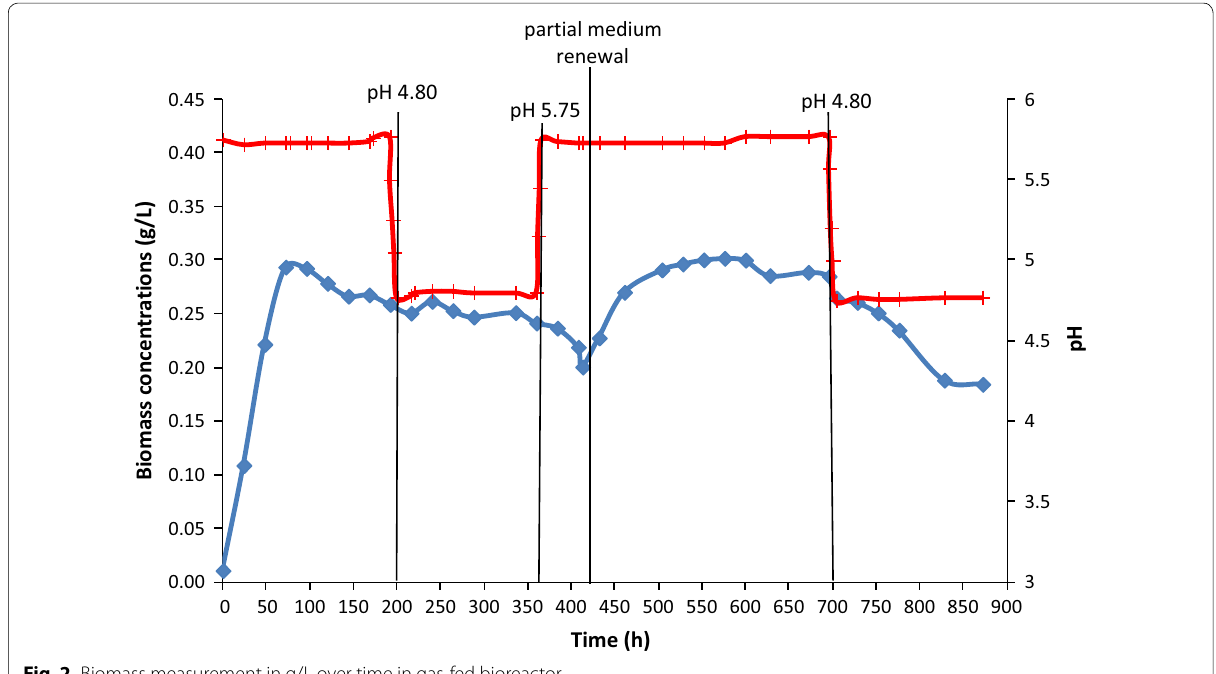
Fig. 2 Biomass measurement in g/L over time in gas‑fed bioreactor